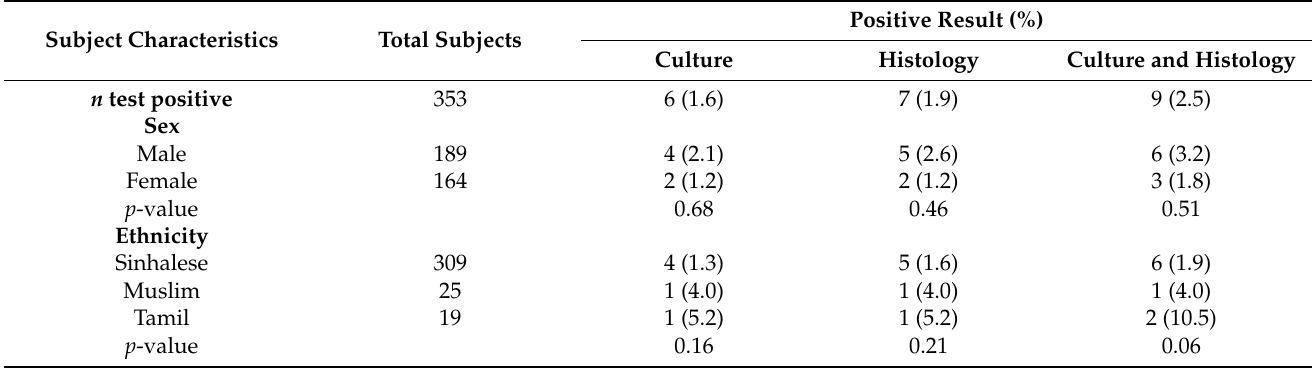
Table 1. H. pylori infection rate by histology and